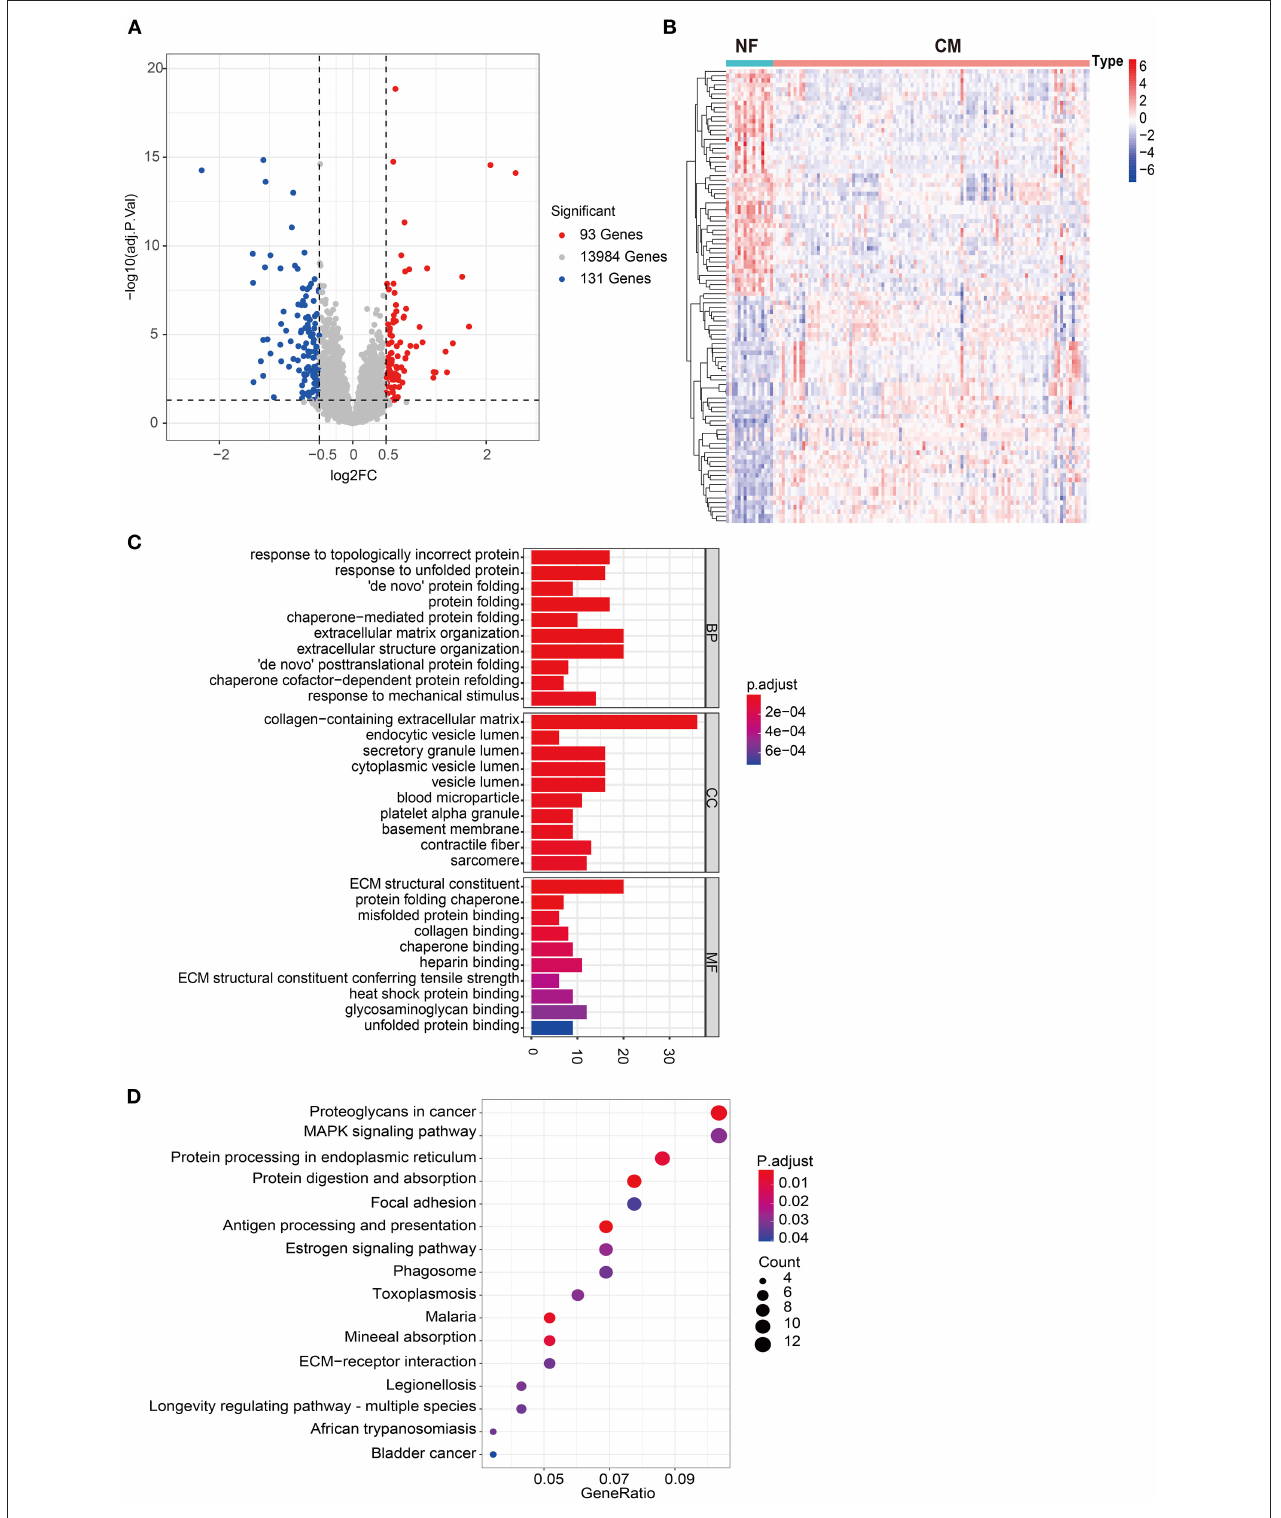
FIGURE 1 | Comprehensive analyses of the transcriptome profiles of NF and CM samples. (A) Volcano plot of significant DEGs between NF and CM samples. (B) A heatmap of the top 50 significantly upregulated or downregulated DEGs. (C) Bar plot of top 10 enriched GO terms of DEGs in each category. BP, biological process; CC, cellular components; MF, molecular functions. (D) Bubble plot of significantly enriched KEGG pathways of DEGs.